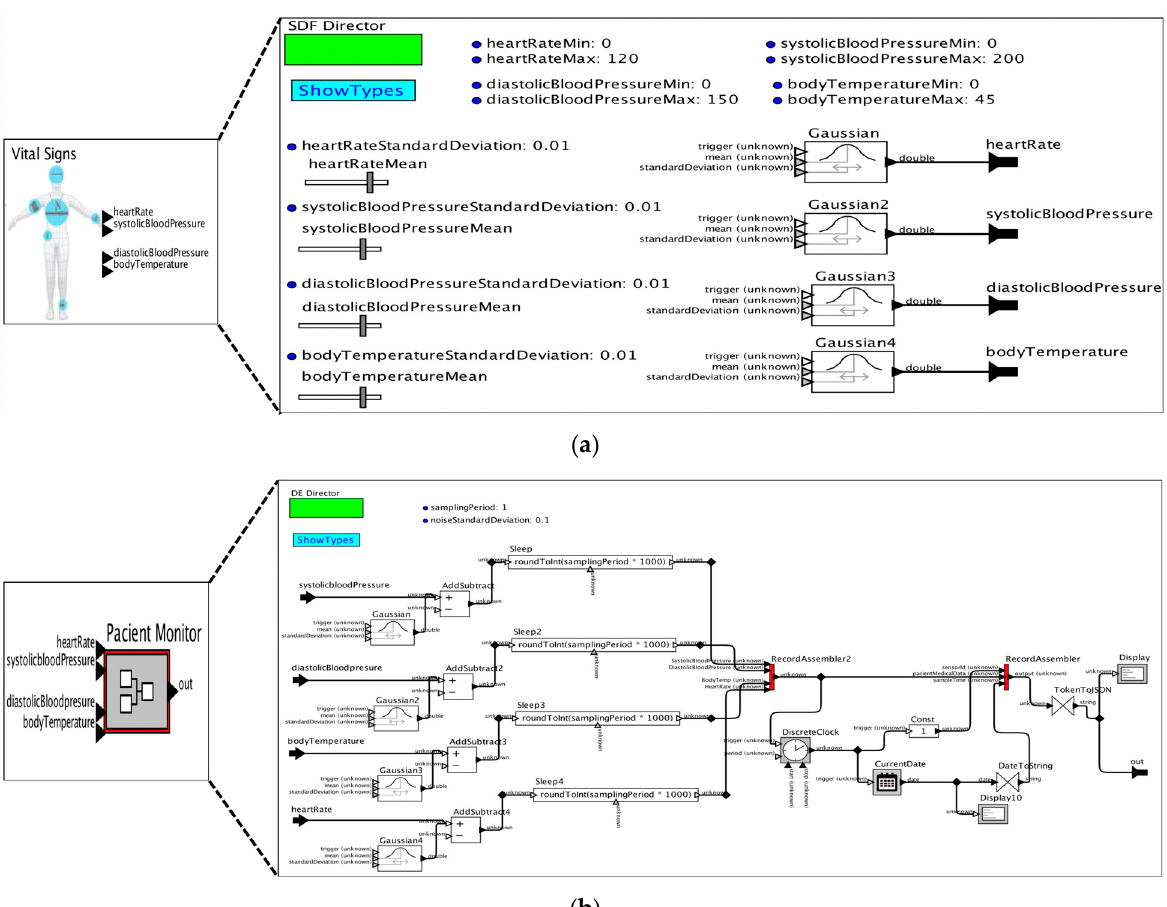
Figure 12. ( a ) The vital sign simulation model uses Gaussian distributions to generate artificial data. Some controls for the parameterization of the simulator are available to simulate certain health conditions. ( b ) The patient monitor model simulates the use of sensors that capture vital sign data. The sampling phases and the structuring of the messages in JSON format are included in the model.